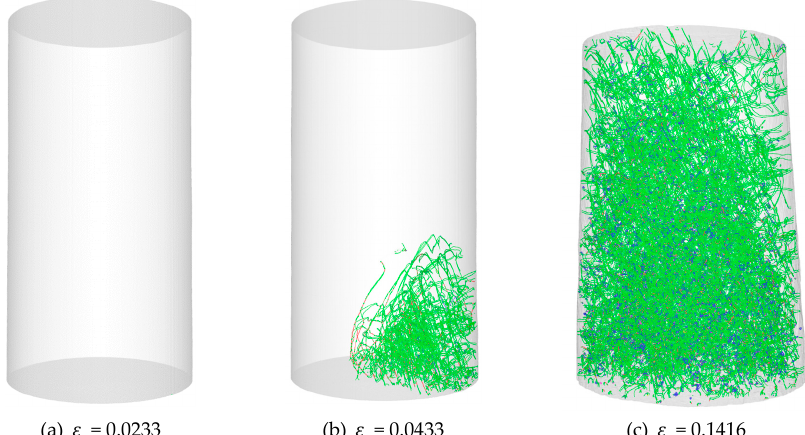
Figure 21. The dislocation network of the pillar with D = 0.15 μ m and H = 0.3 μ m during micropillar compression test at different strains of: ( a ) 𝜀 = 0.0233; ( b ) 𝜀 = 0.0433; ( c ) 𝜀 = 0.1416 (after Yaghoobi and Voyiadjis [21]).